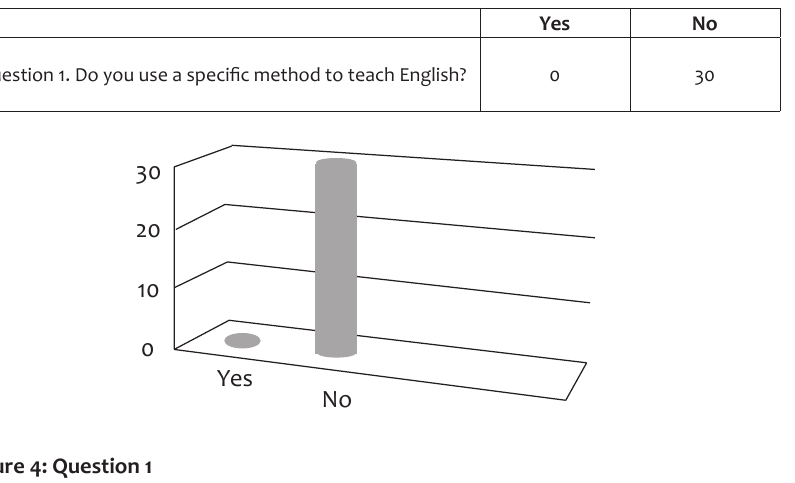
Table 4: Approach to second language teaching